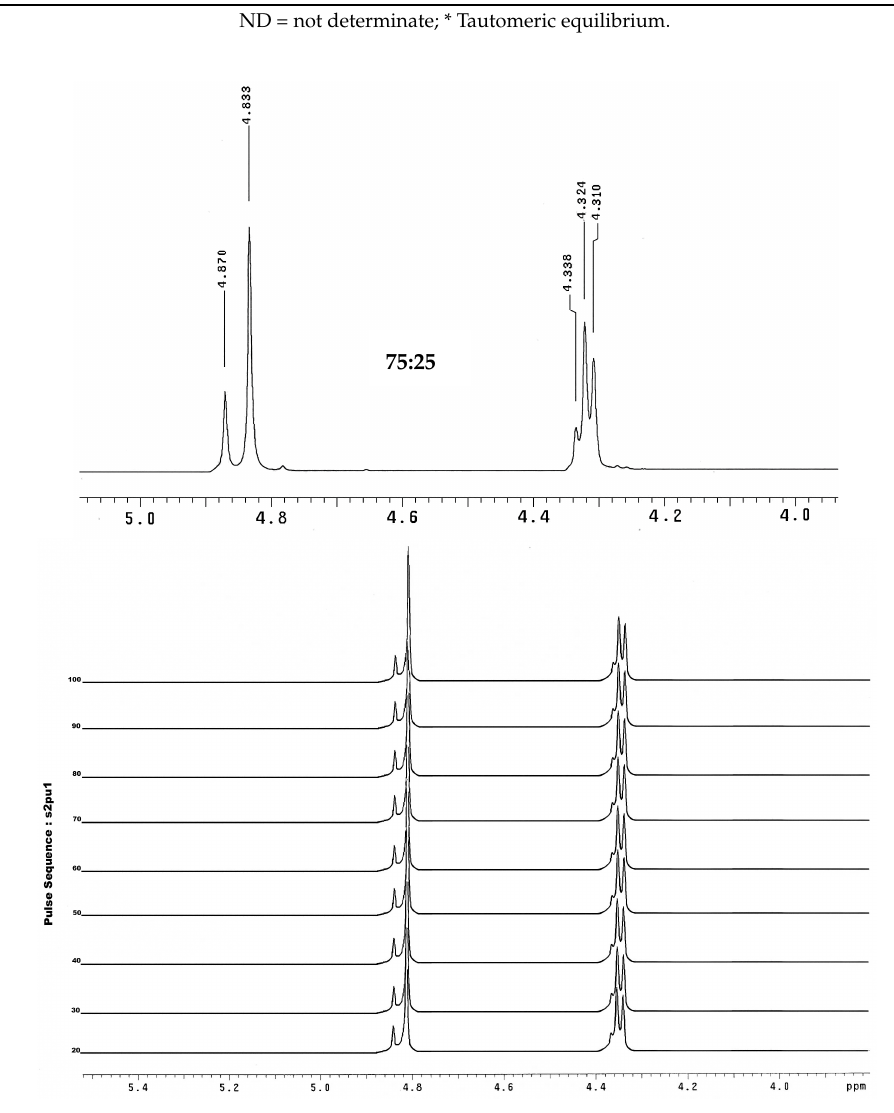
Table 2. Physicochemical properties, and in vitro antiprotozoal bioactivity benznidazole analogues 1 – 8 . Cmpd. Cmpd